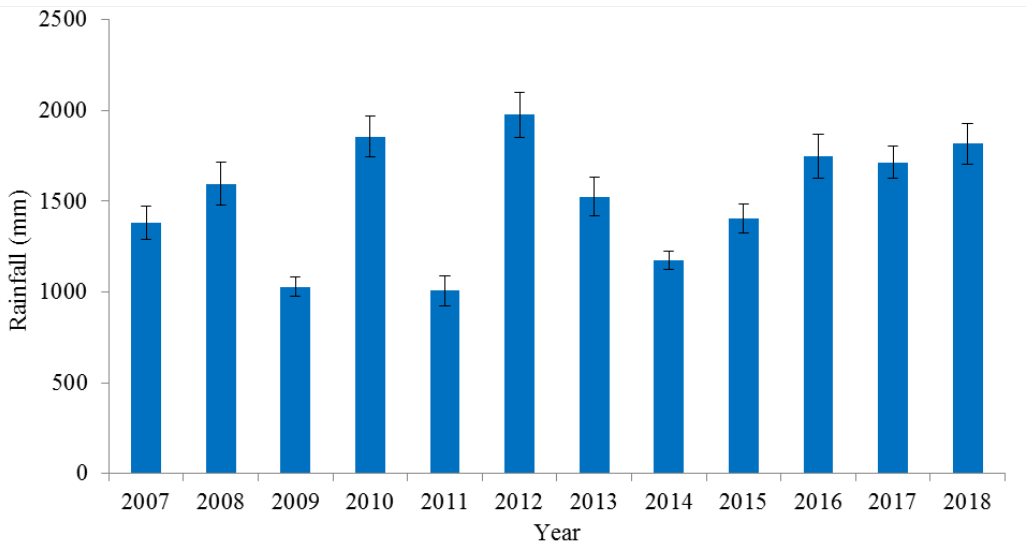
Figure 4. Average annual rainfall in Nverzhai Basin from 2007–2018.